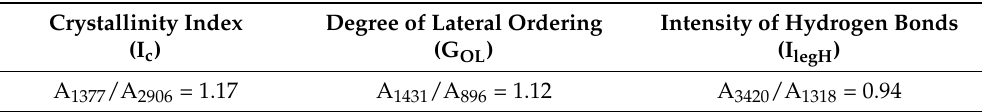
Table 1. Crystallinity index, Degree of lateral ordering, Intensity of hydrogen bond, which were evaluated from the IR spectra of the spruce wood